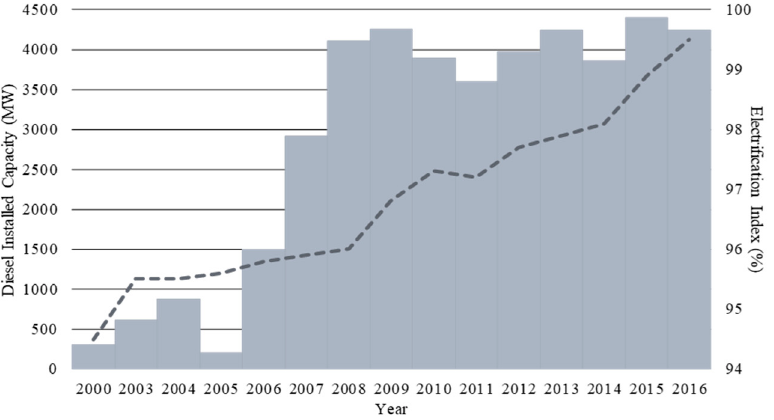
Figure 2. Growth in installed capacity of generator sets and electrification rate in Cuba.